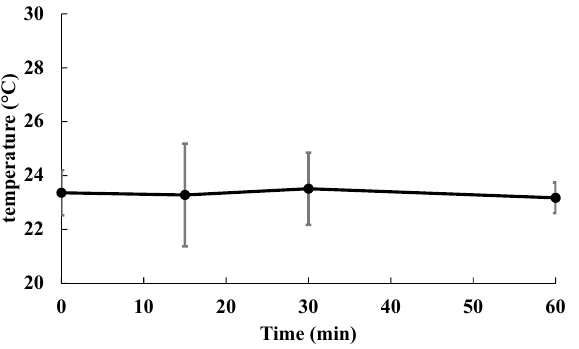
Figure 5. Temperature changes induced in bacterial samples by MIR-FEL